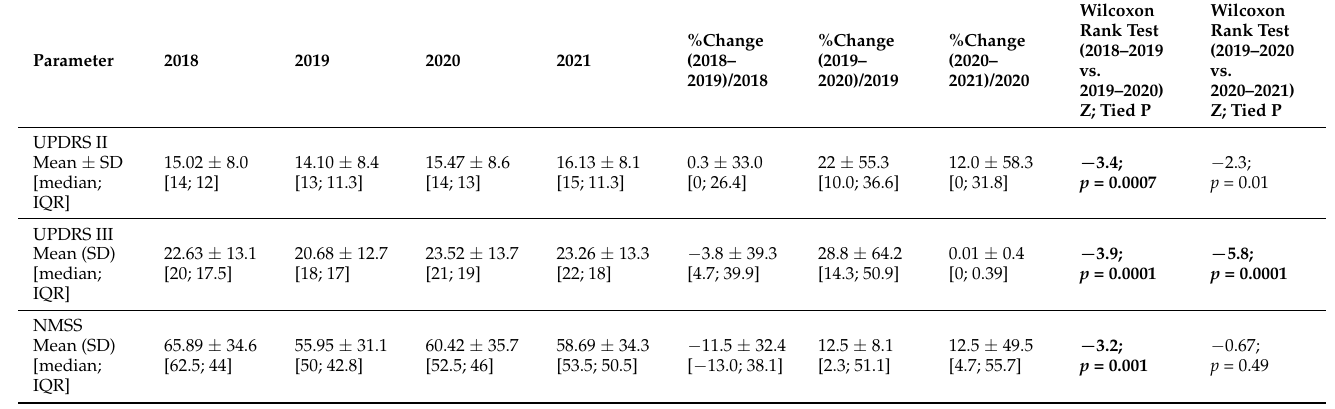
Table 1. Clinical and functional status scores collected on 221 patients with PD from 2018 to 2021. Main outcome changes at the end of each period of interest are described as a percentage of the change compared to the starting value. Statistically significant comparisons are indicated in bold.